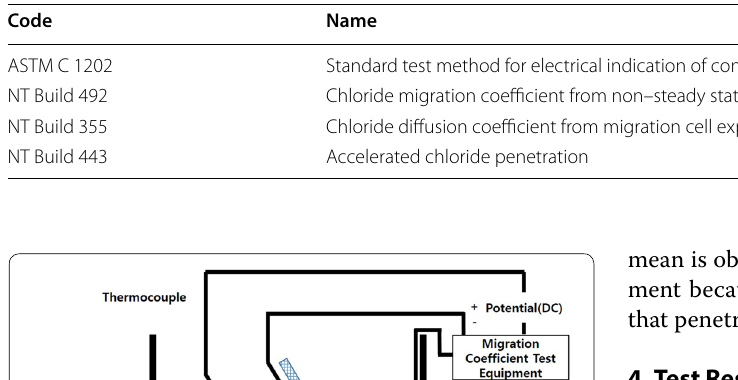
Table 3 Concrete chloride experimental type.